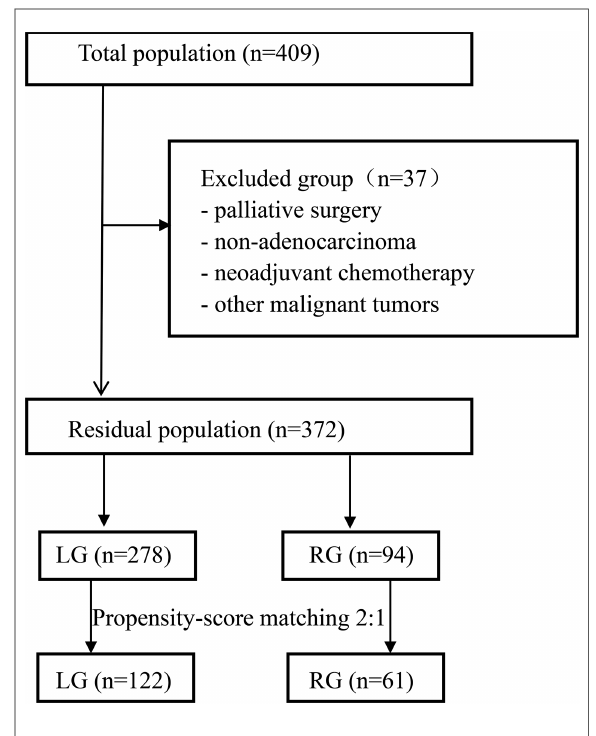
FIGURE 1 Selection schema of patients. LG, laparoscopic gastrectomy; RG, robotic